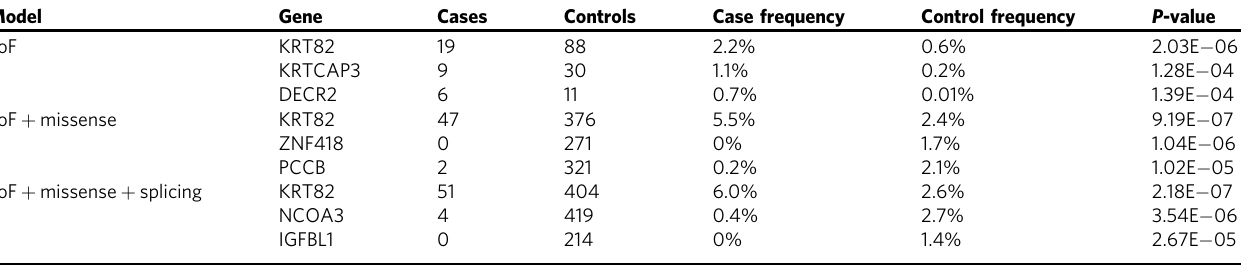
p -value was determined by two-tailed Fisher ’ s exact test